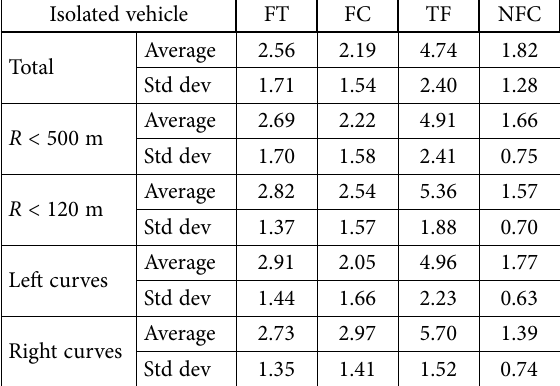
Table 1. Values of the FT, FC, TF and NFC indicators in an ‘isolated vehicle’ condition Isolated vehicle